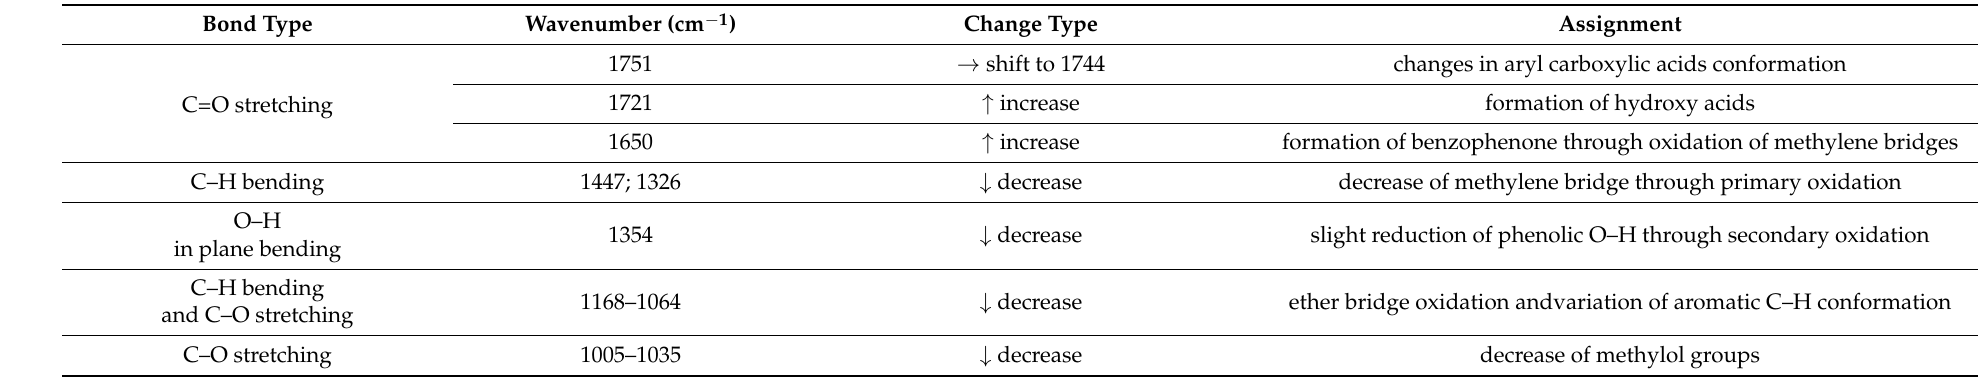
Table 4. General changes detected by µ -FTIR on the phenol formaldehyde (PF) foams by comparing the spectra of the “Unaged” and Naturally Aged open- and closed-cell PF